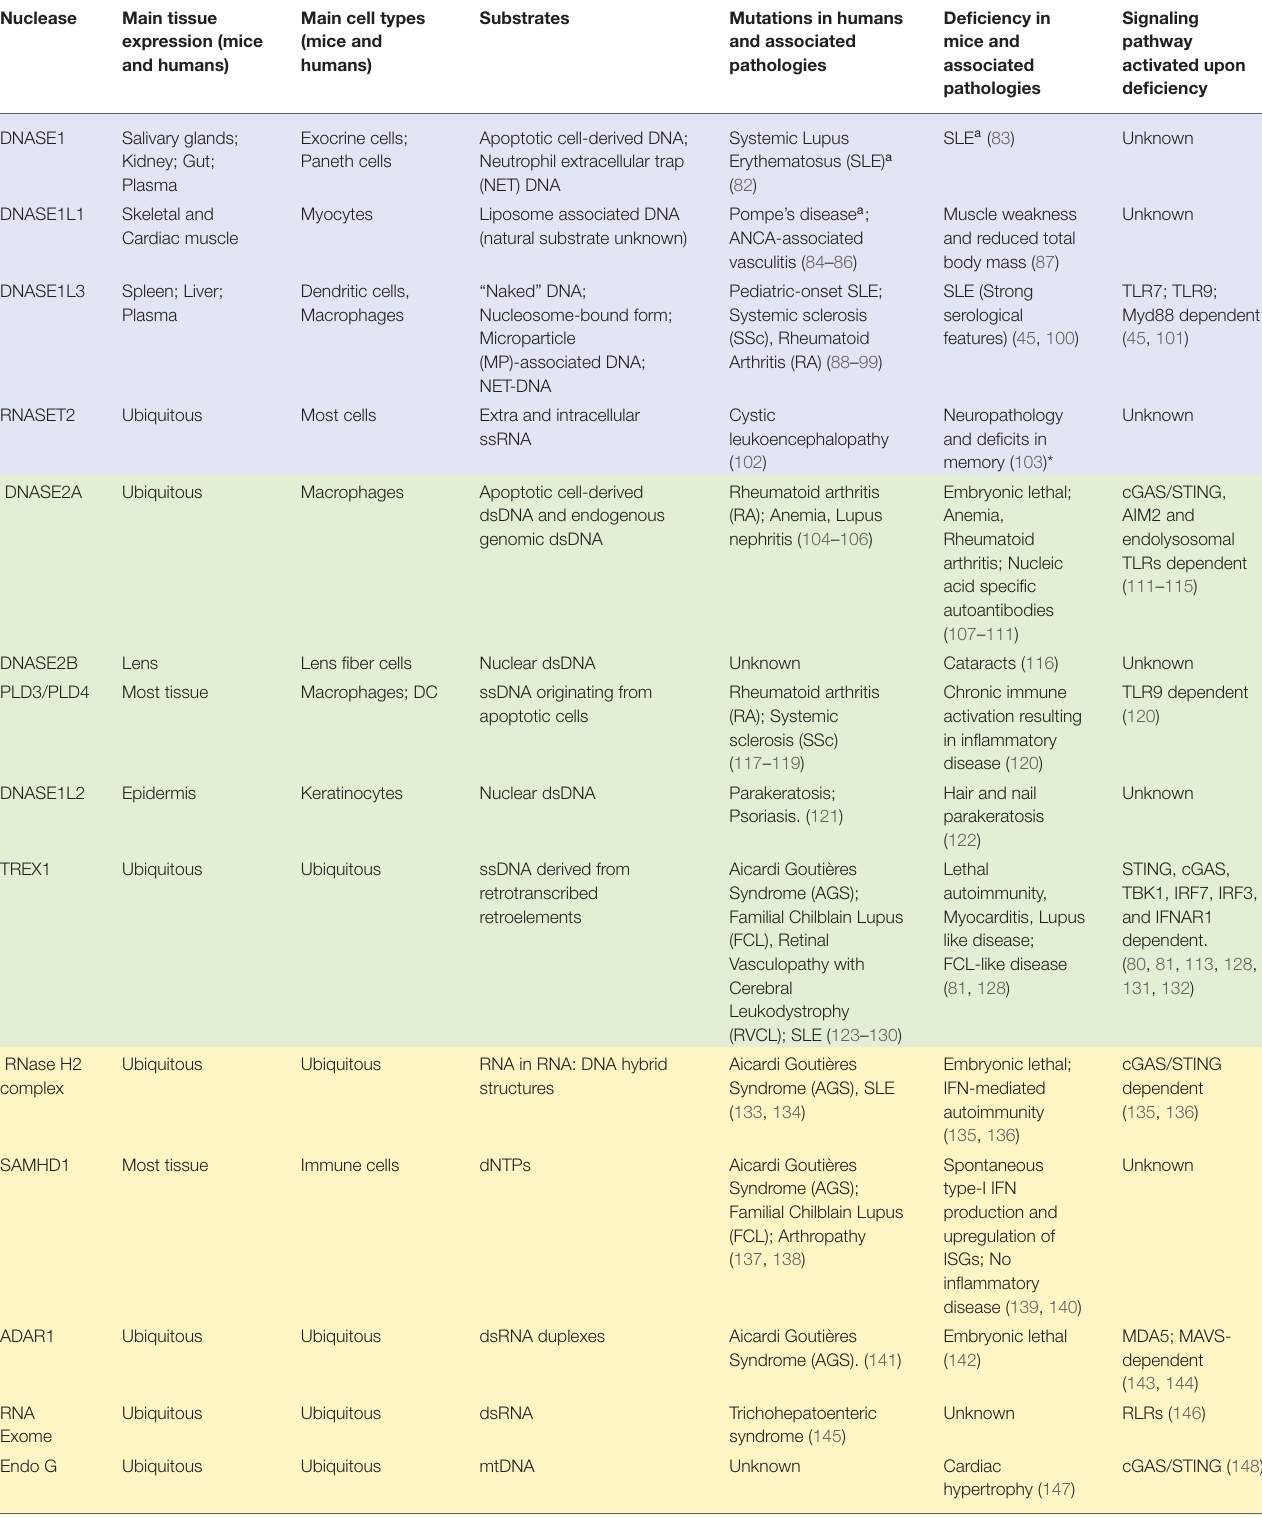
Blue are extracellular, Green are endolysosomal and yellow are intracellular nucleases or NA processing enzymes. a Controversial; * Study in